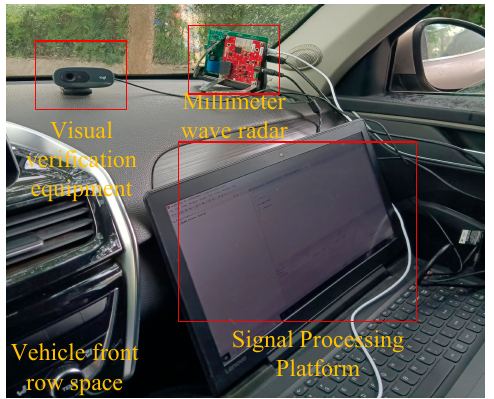
Figure 6. Multimodal low-rank factor normalized representation process.